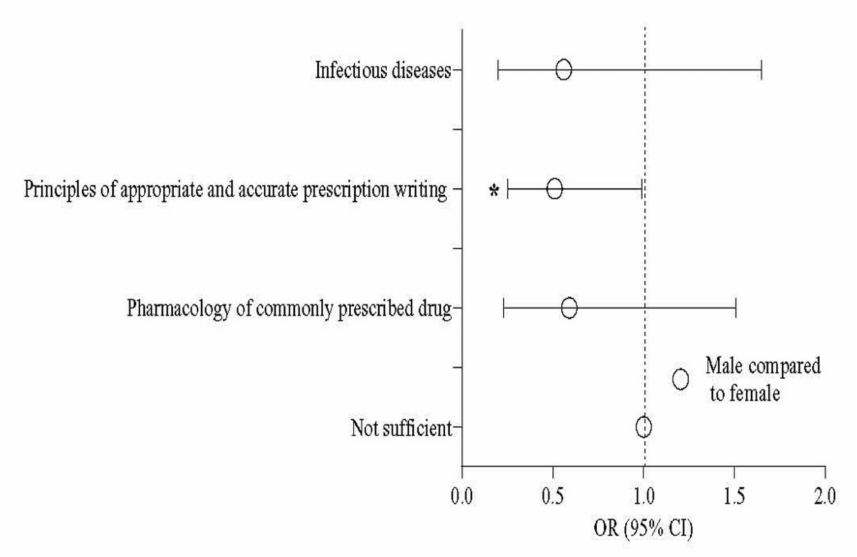
Figure 1. Odds of gender in the formal education and training on pharmacology. Note : * p < 0.05. Circles indicate the estimation of odds